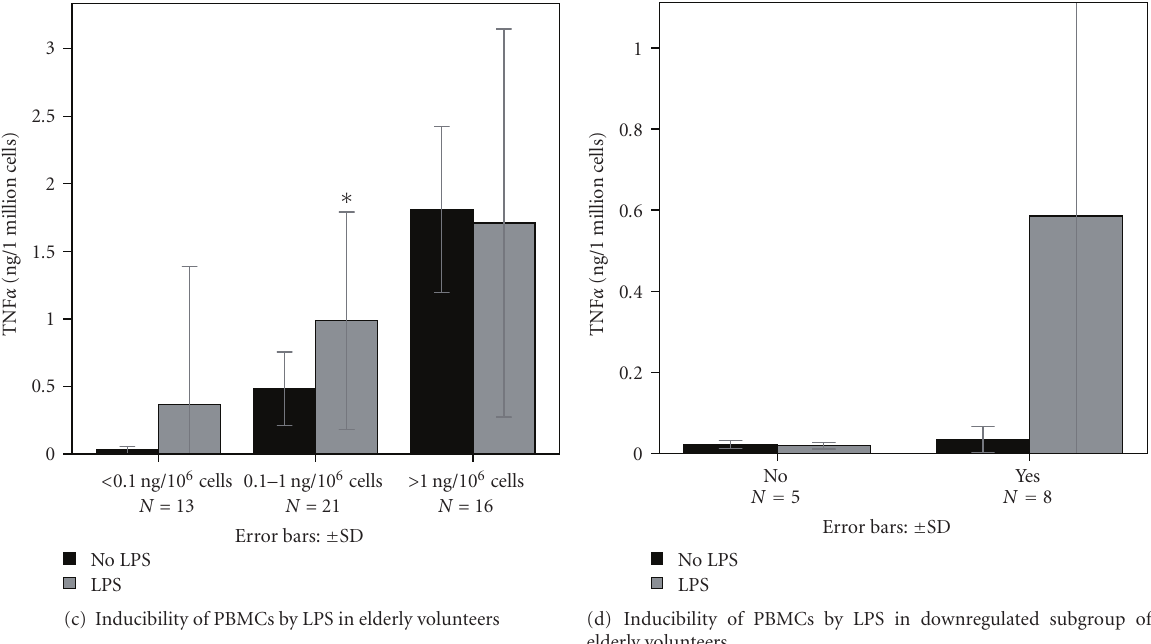
Figure 2: In vitro TNF α productions by peripheral blood mononuclear cells (PBMCs) of elderly volunteers demonstrate significant interindividual di ff erences in this group (a) based on the order of TNF α production (b) three subgroups can be distinguished: downregulated, intermediate regulated, and upregulated (c) no response to endotoxin (LPS) was found in upregulated and in the majority of downregulated groups (c, d), ∗ P < 0 . 05 stimulated versus